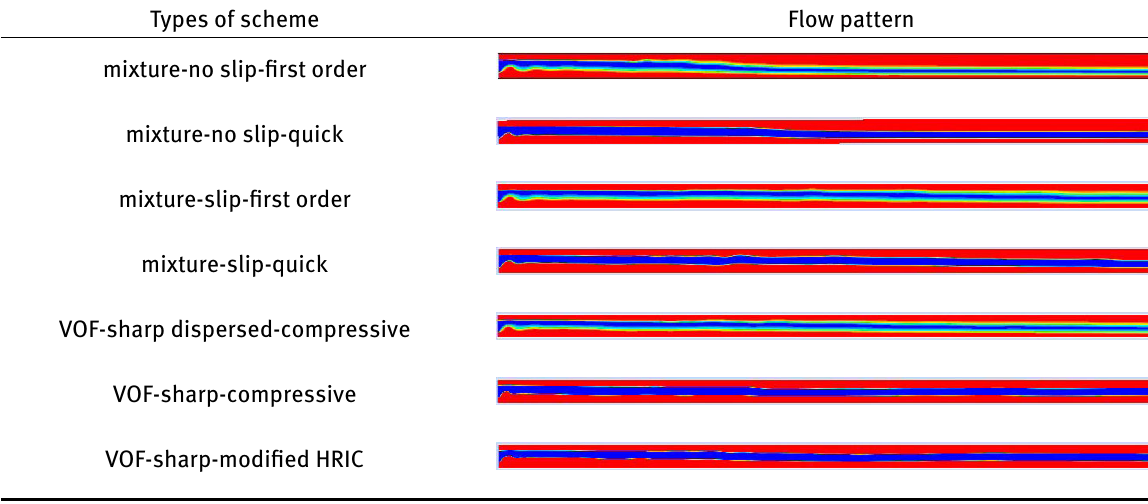
Table 16: Inter the kerosene from the middle two-phase flow patterns, (L = 3 m, H = 10 cm), mesh (1040000) Types of